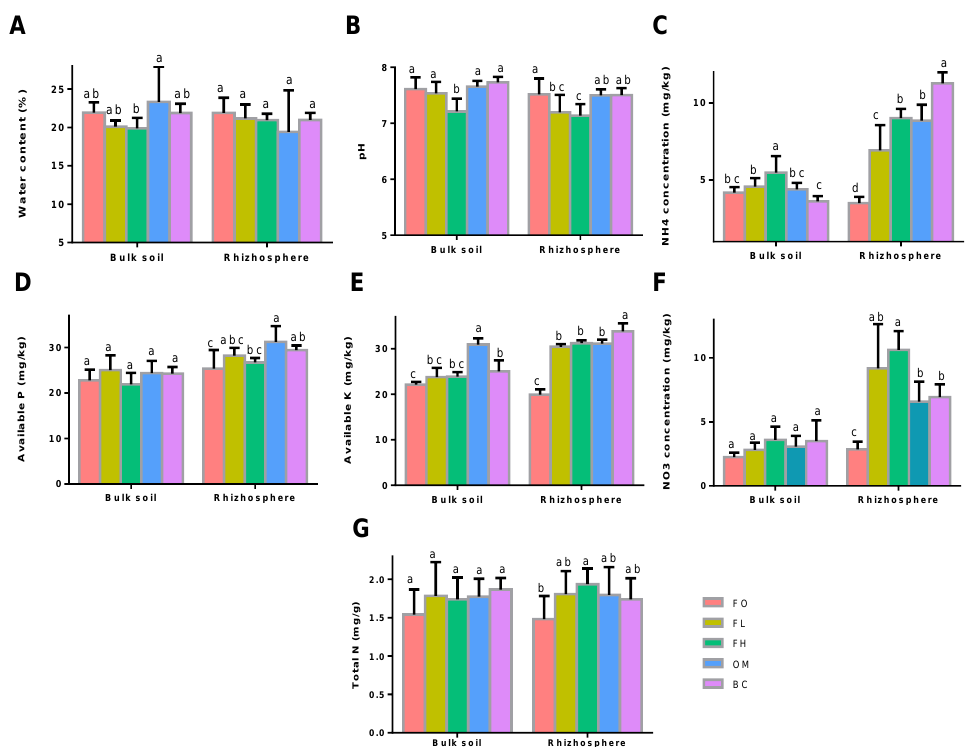
Figure 1. Effect of the treatments on selected soil properties before wheat harvest. Soil properties measured include ( A ) water content (%); ( B ) pH; ( C ) ammonium (NH 4+ -N) concentration (mg kg −1 ); ( D ) nitrate-nitrogen (NO 3 − -N) concentration (mg kg −1 ); ( E ) available phosphorus; ( F ) available potassium; and ( G ) total nitrogen (mg g −1 ). FO: no fertilizer, control; LF: low fertilizer; HF: high fertilizer, OM: manure; and BC: biochar. Values are the means of the eight replicates of each treatment. The different alphabet letters indicate that there are significant differences (ANOVA, LSD test, p < 0.05) among fertilizer treatments. The error vertical bars represent standard error bars.